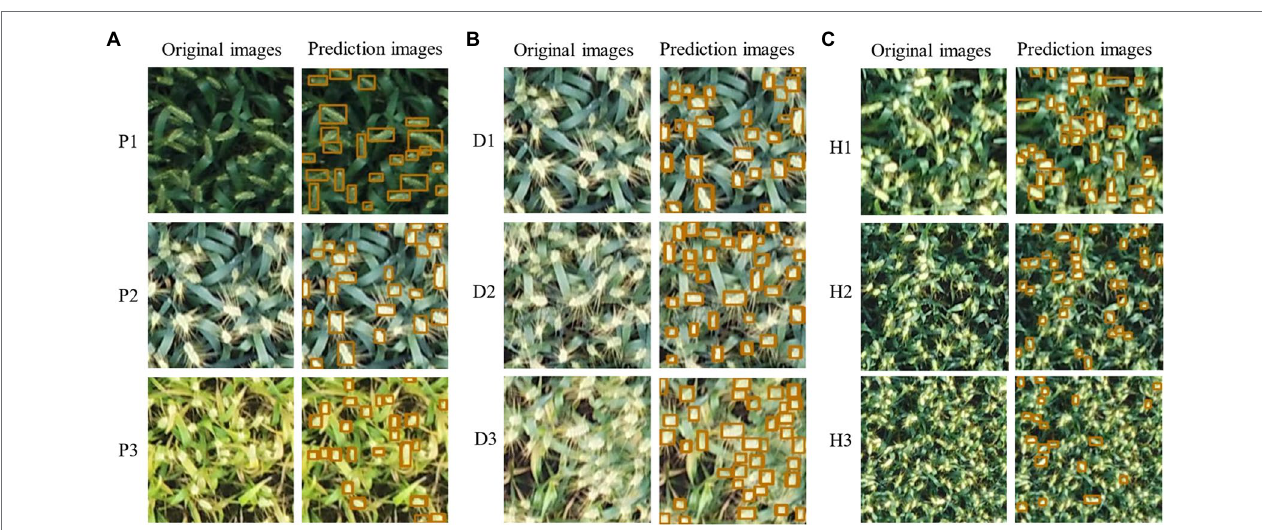
FIGURE 7 | Prediction effect of the improved model on the three series datasets: (A) P series, (B) D series, and (C) H